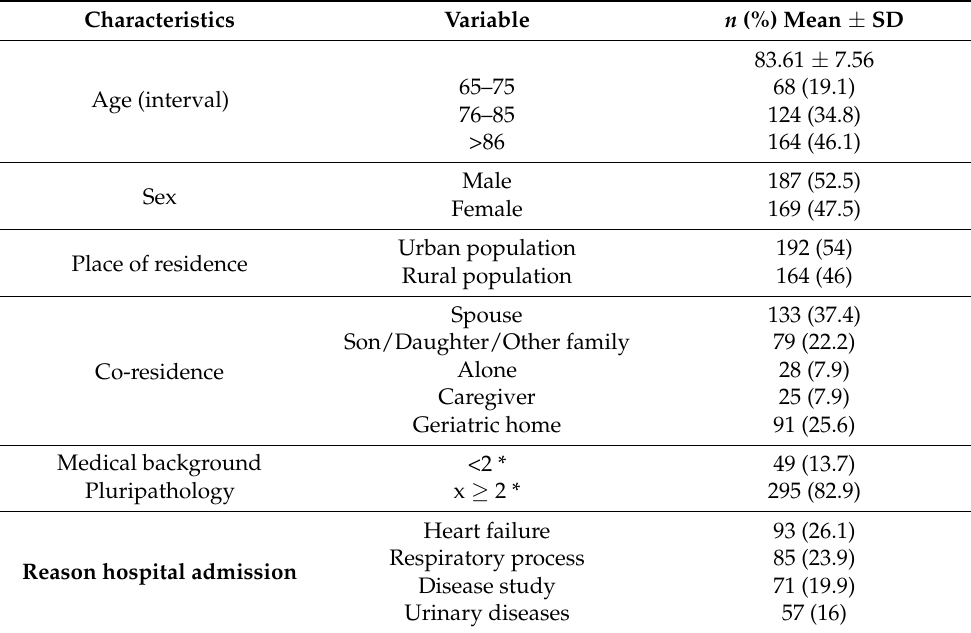
Table 1. The sociodemographic data of the total sample.